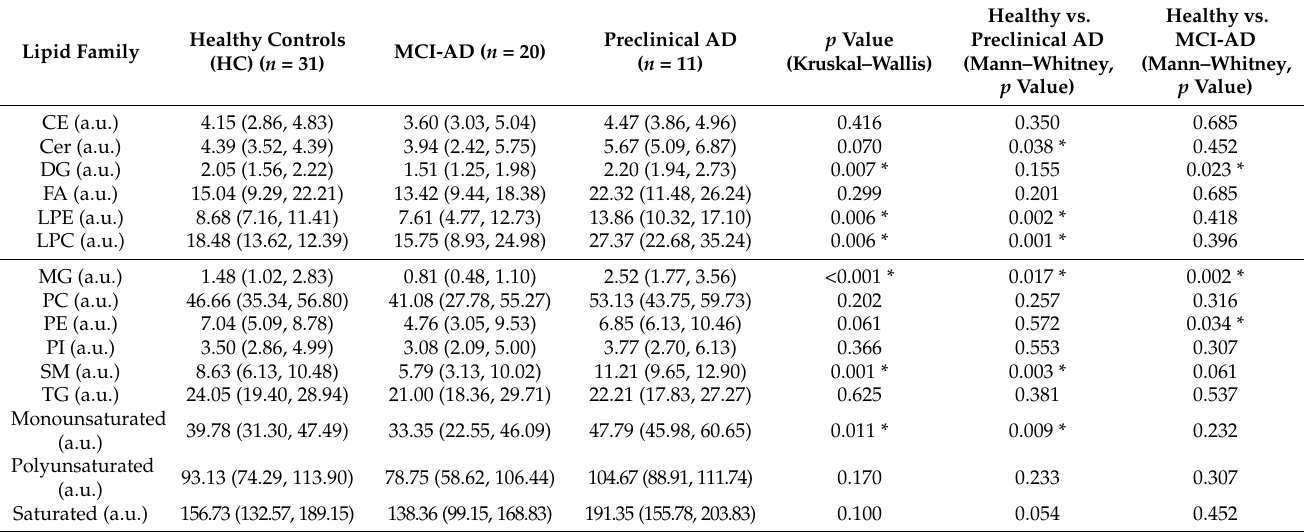
Table 3. Average sum of the different lipid families’ levels in the participant groups (preclinical AD, MCI-AD, and